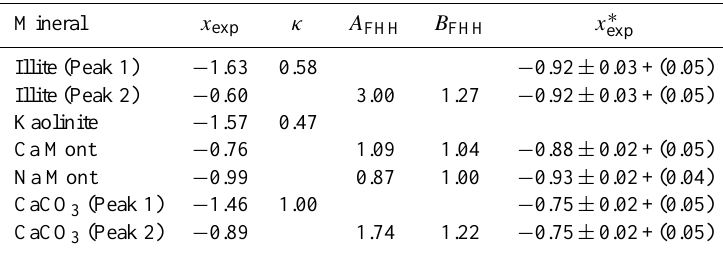
Table 2. CCN activation results – experimental exponent, hygroscopicity parameter ( κ ), adsorption parameters ( A FHH , B FHH ) for clays and calcite sample generated from wet atomization method.